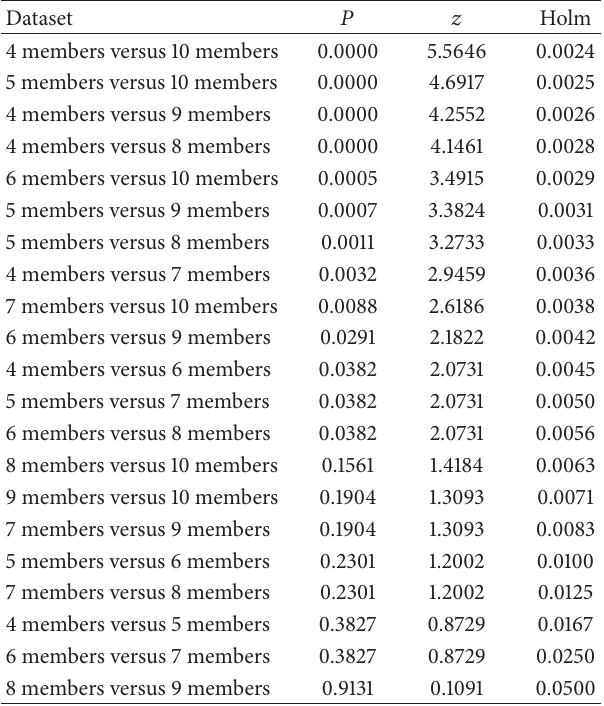
Table 12: Holm procedure on the effect of group size.